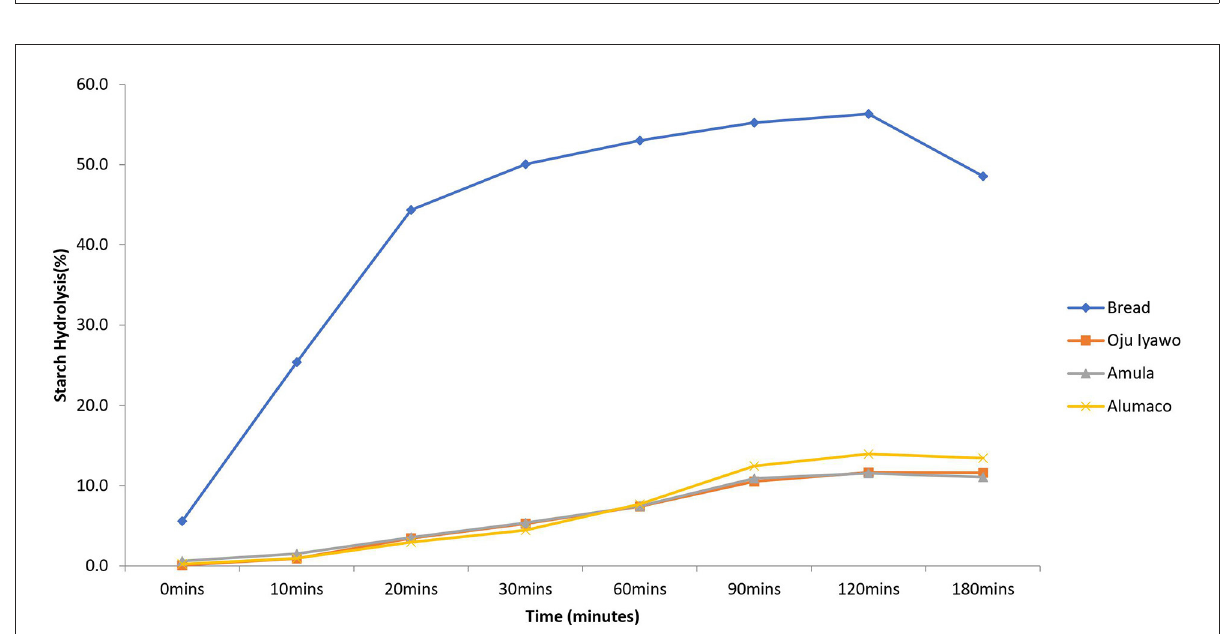
FIGURE4 Rate of in-vitro Starch Hydrolysis in Pounded yam made from three varieties of Yam.